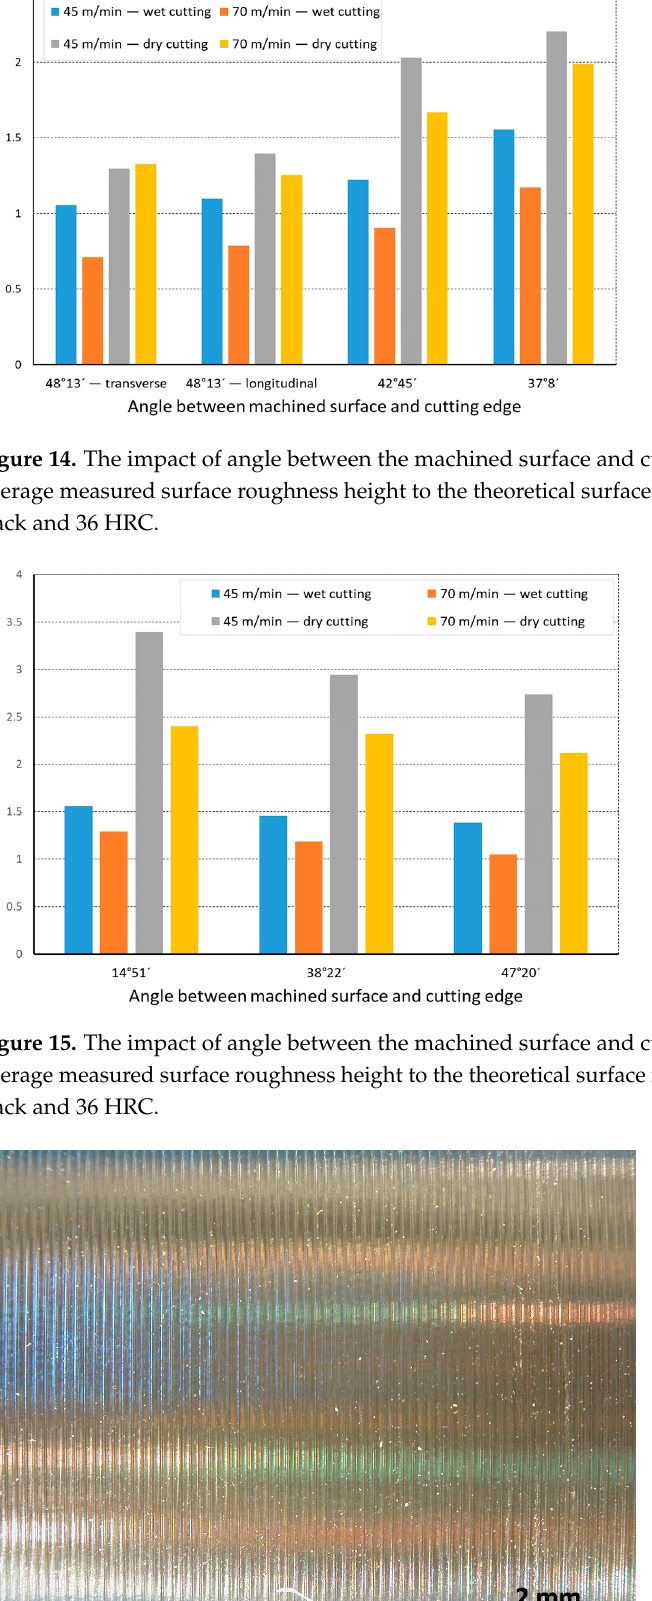
Figure 13. The impact of angle between the machined surface and cutting edge on ratio Δ Rz of the average measured surface roughness height to the theoretical surface roughness Rz to for a curvilin- ear track and 23 HRC.